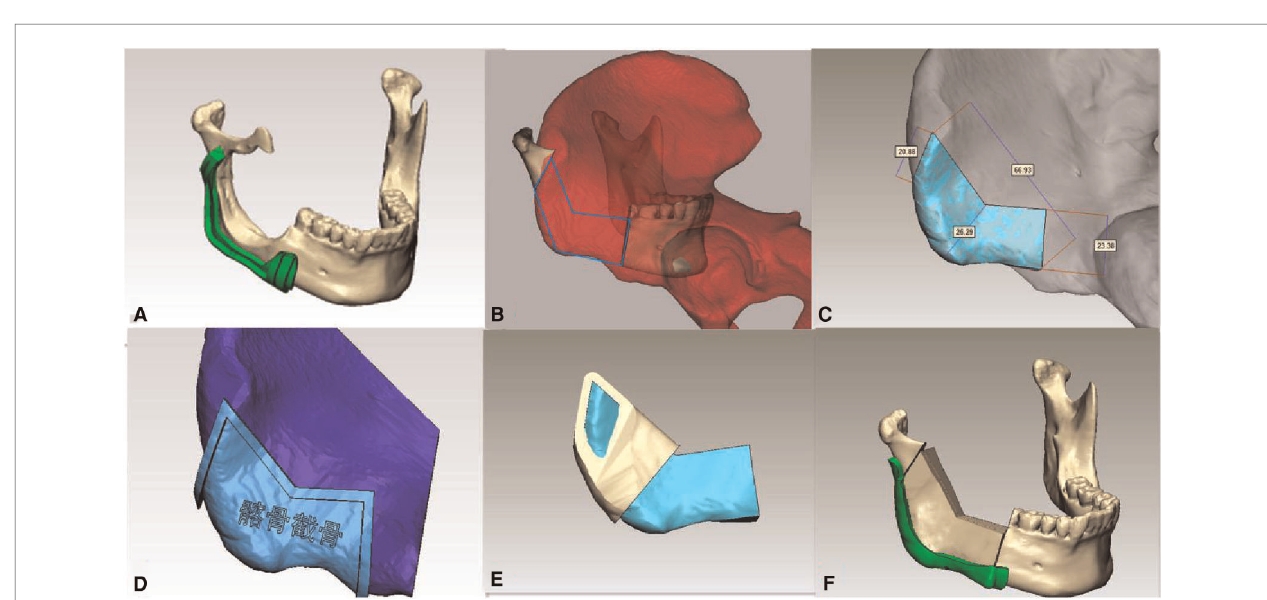
FIGURE 2 | Virtual model created by computer-aided design (CAD); the osteotomy line and surgical cutting guides for the mandible were designed fi rst ( A ); the model of the defect region was used to look for the most matching region in the Iliac bone model, and we found that the most matching region was on the left iliac bone. The anterior superior iliac spine would be used to reconstruct the angle of the mandible, the iliac crest would be used to reconstruct the posterior border of the mandible ramus, and the anterior border of the iliac wing would be used to reconstruct the inferior border of the mandible; the natural curvature of left Iliac bone could complement the curve of the mandible perfectly and can be placed accordingly to fi ll the defect ( B ); then, the virtual iliac bone graft model was obtained ( C ), which was used to design the bone graft cutting guide ( D ), shaping guide ( E ), and fi xation guide ( F